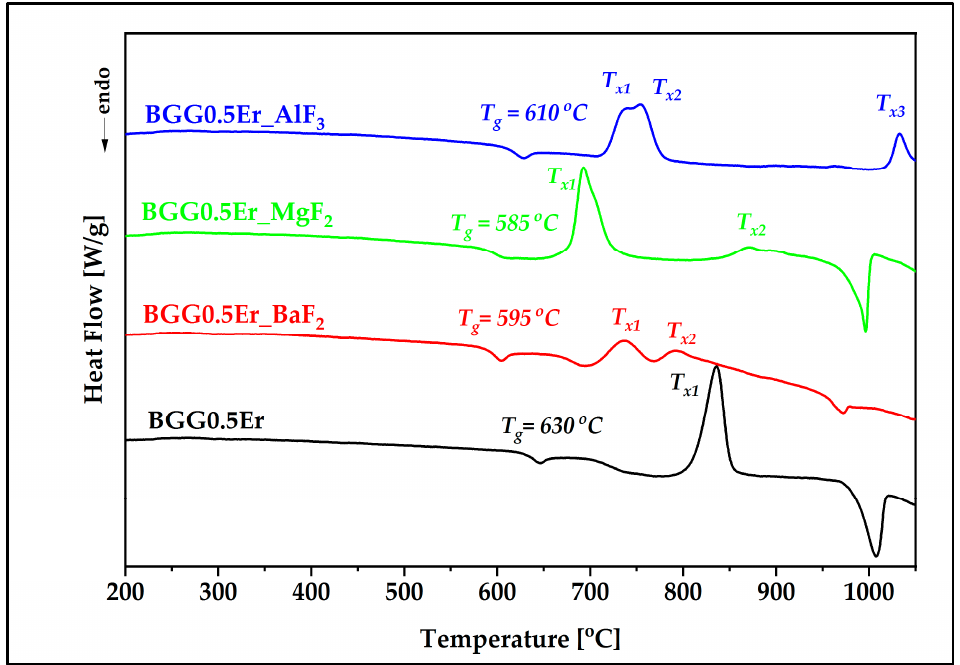
Figure 2. DSC curves of BGG0.5Er glass modified by BaF 2 , MgF 2 , and AlF 3 . Table 1. Thermal properties of erbium-doped BGG glass modified by fluorides.